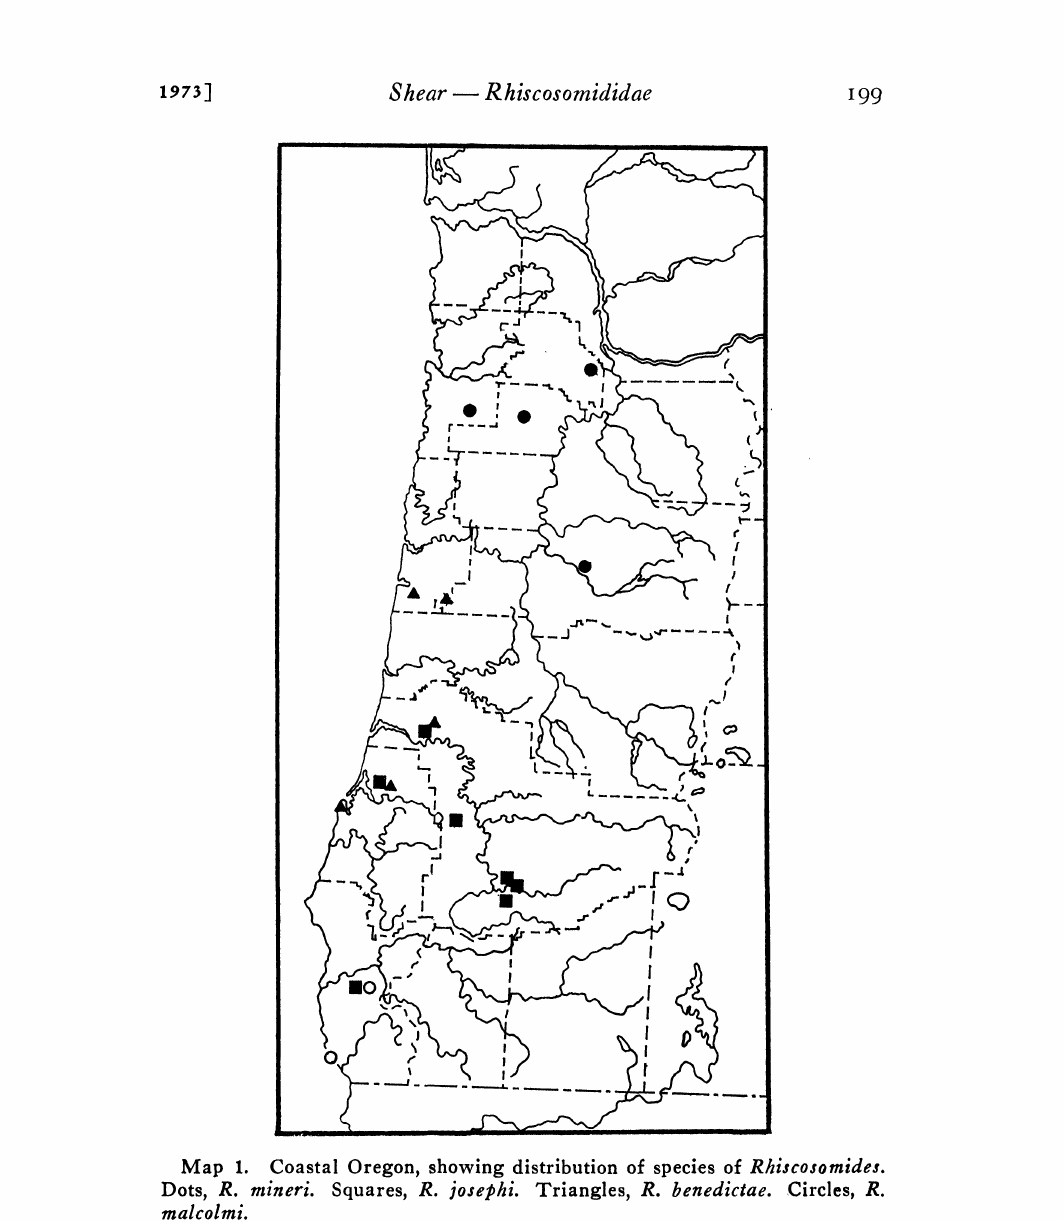
Map 1. Coastal Oregon, showing distribution of species of Rhiscosomides. Dots, R. mineri. Squares, R. josephi. Triangles, R. benedictae. Circles, R.